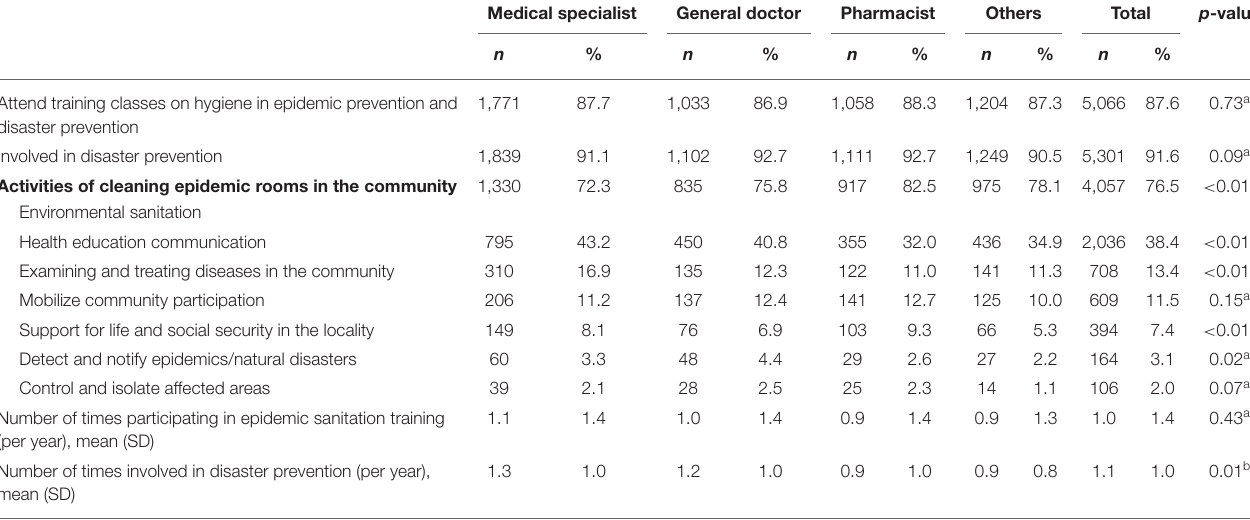
TABLE 2 | Training and practice for epidemic control among medical